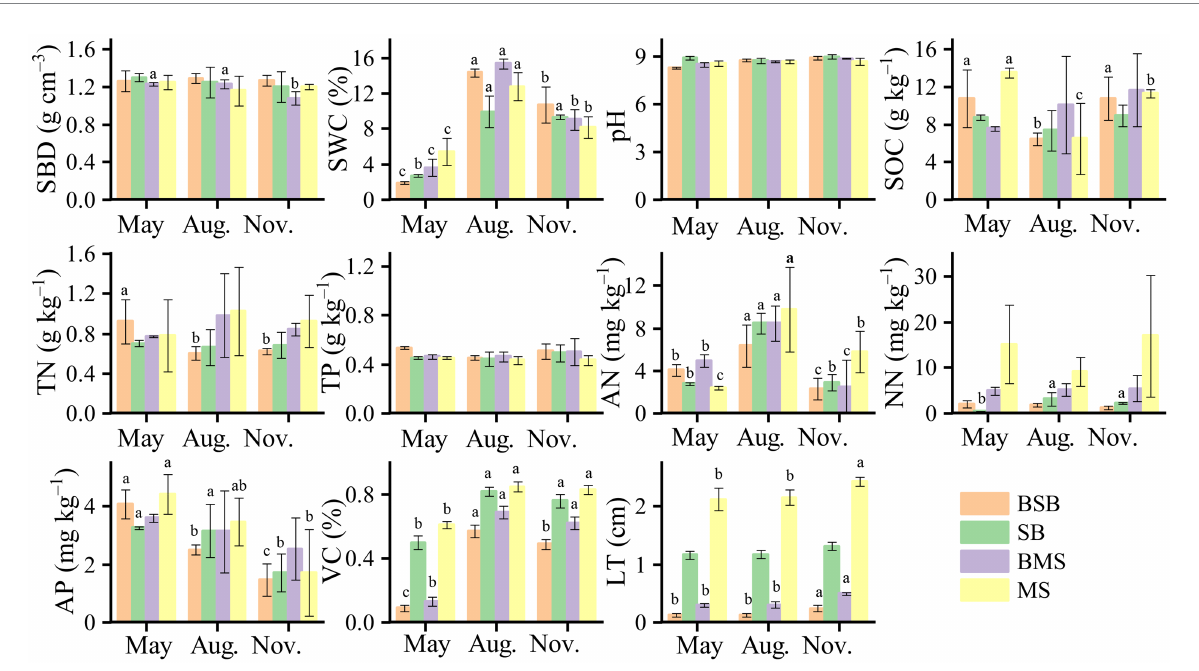
FIGURE 6 Properties of soil and vegetation in Stipa bungeana habitat (SB), Burned Stipa bungeana habitat (BSB), Medicago sativa habitat (MS), and Burned Medicago sativa habitat (BMS). Different lowercase letters denote significant differences among different sampling times (ANOVA with LSD test, p < 0.05). SWC, Soil water content; SBD, Soil bulk density; pH, Soil pH; SOC, Soil organic carbon; TN, Soil total nitrogen; TP, Soil total phosphorus; AP, Available phosphorus; AN, Ammonia nitrogen; NN, Nitrate nitrogen; VC, Vegetation coverage; LT, Litter